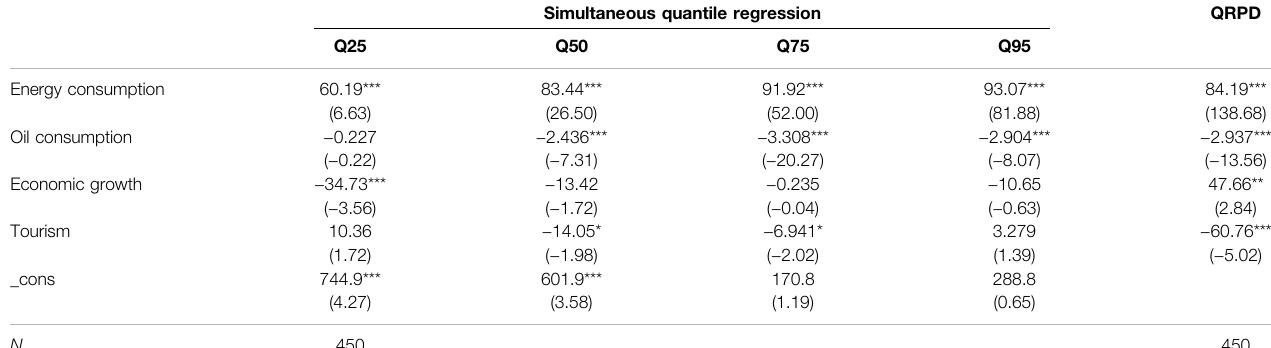
TABLE 7 | Robustness check with quantile regression.